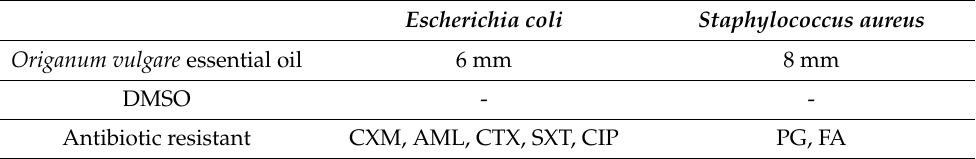
Table 3. Inhibition zone generated by Origanum vulgare essential oil on bacteria studied and list of antibiotics that bacteria have